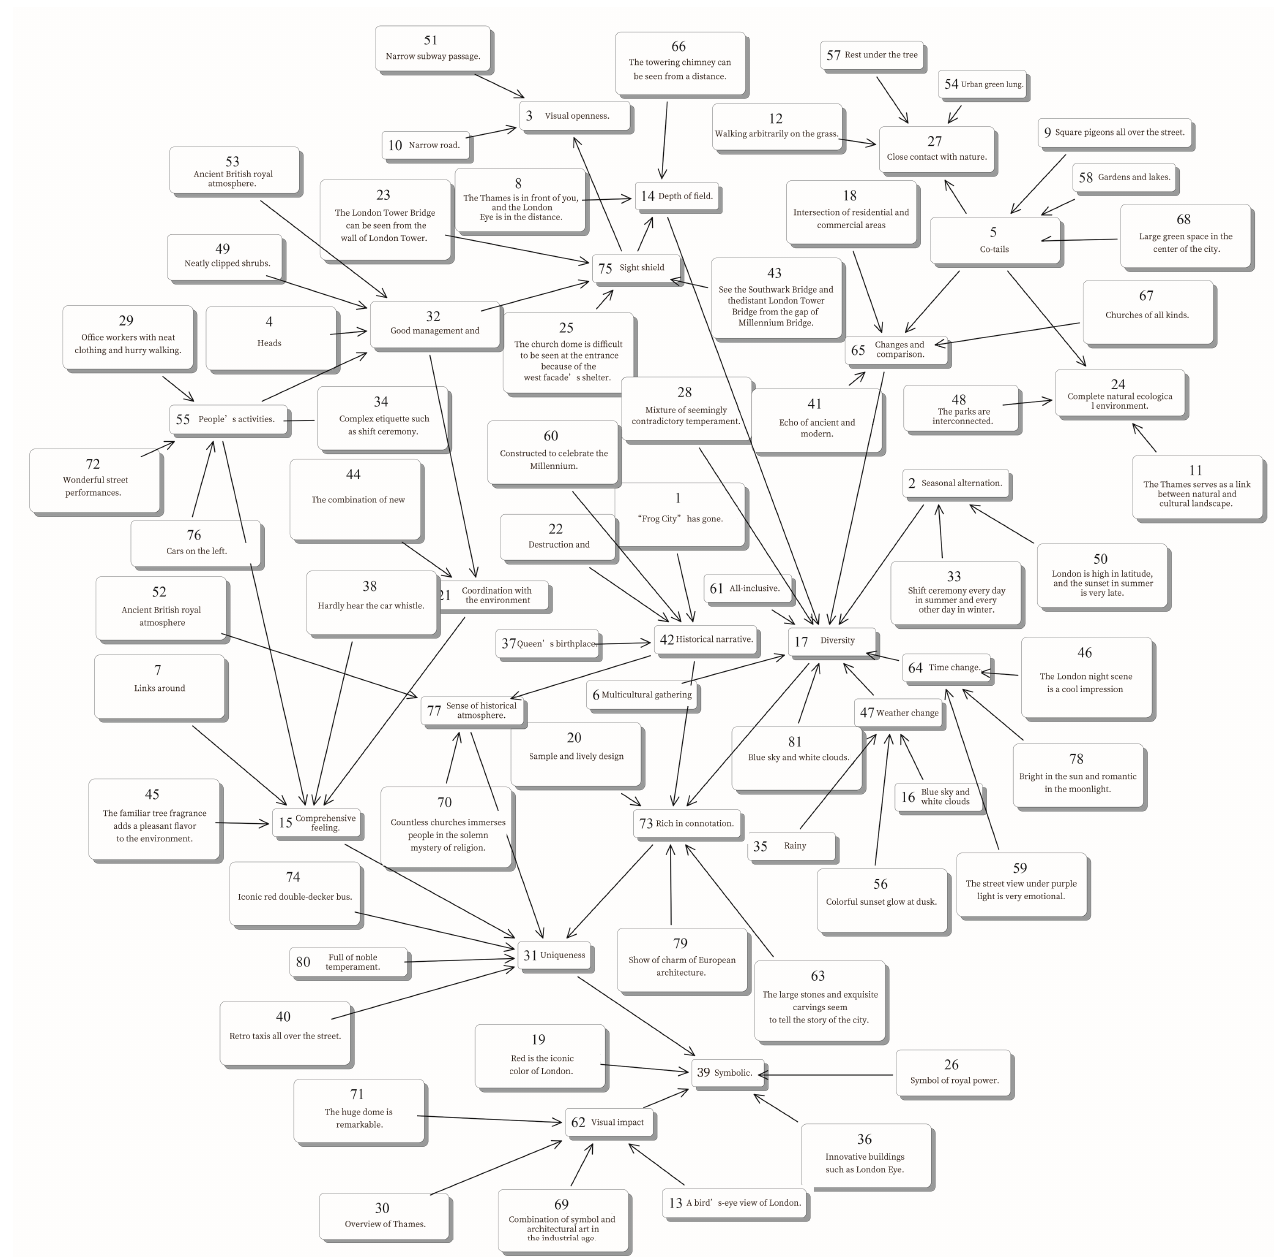
Figure 3. Cognitive Map of Urban Landscape Aesthetics of London (Output by Decision